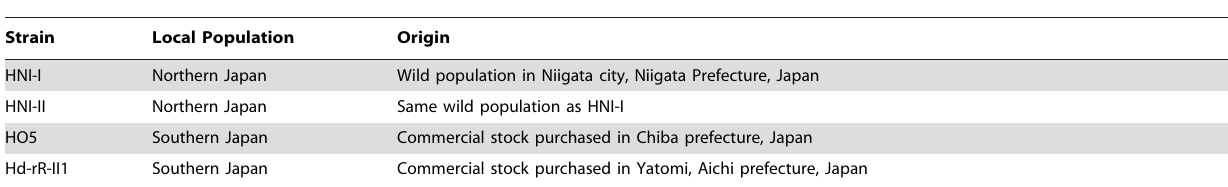
Table 1. Inbred Strains and Their